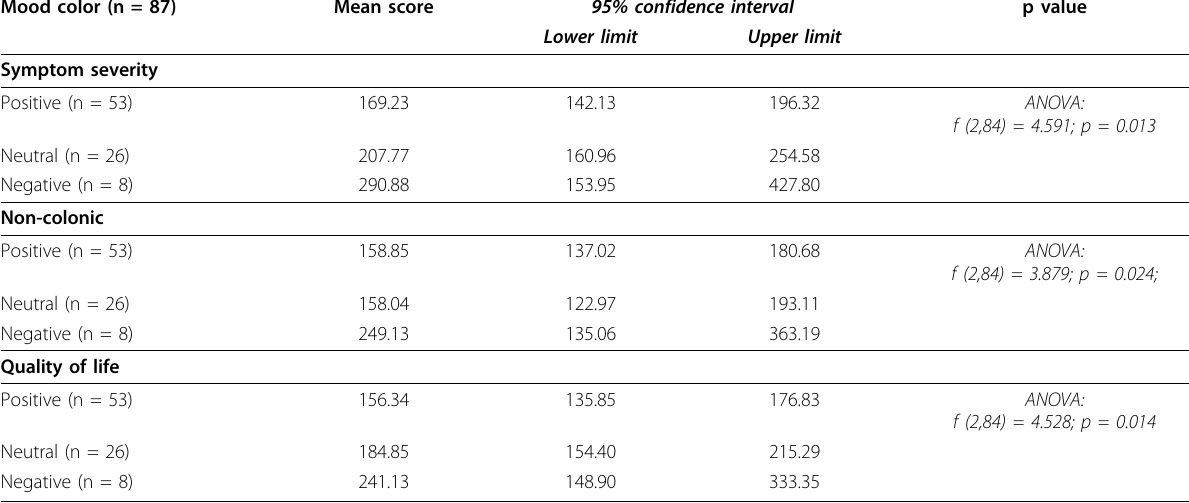
Table 7 Association between post-HT symptom severity, non-colonic and quality of life scores and post-HT mood color choice